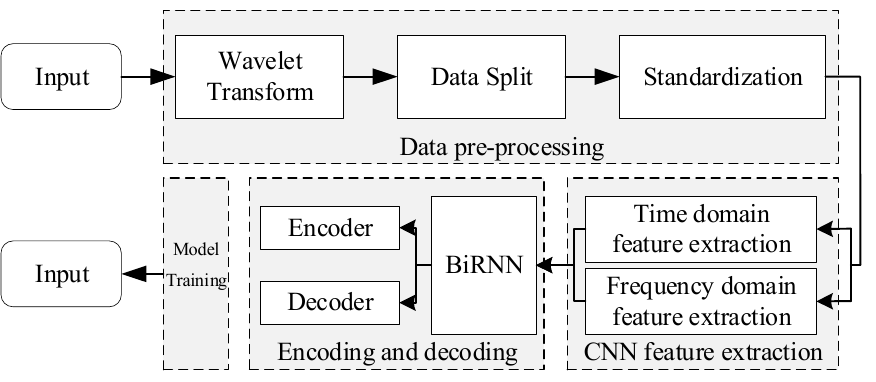
Figure 1. Structure of the proposed model.